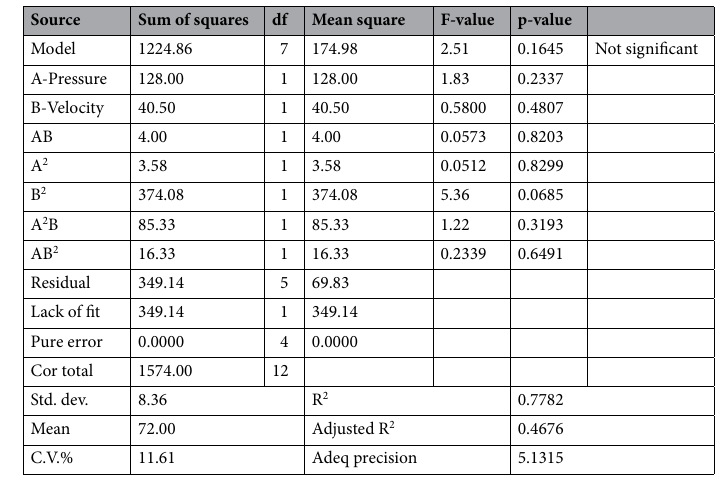
Table 20. ANOVA results for quadratic model (exploitation zone is response) of QAM f .